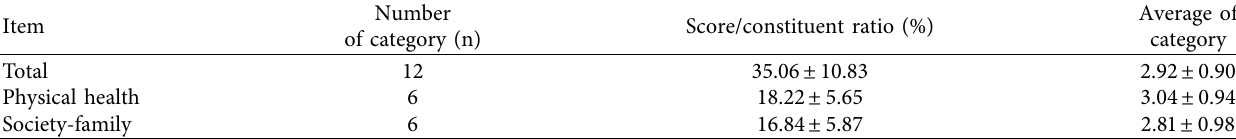
Table 2: Grade of FCR in breast cancer patients and score.